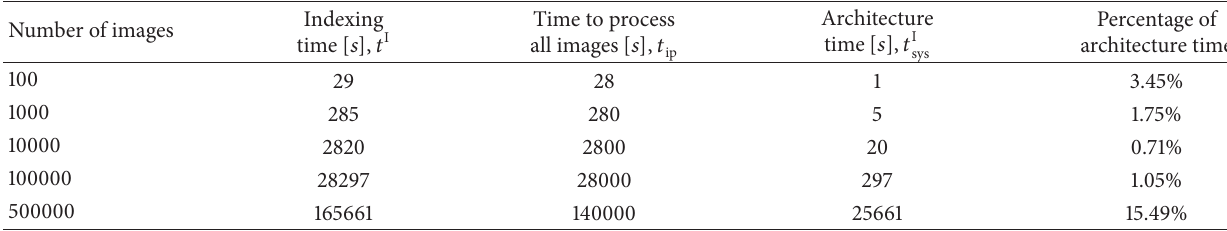
Table 1: Indexing phase performances (i.e., Hadoop based).